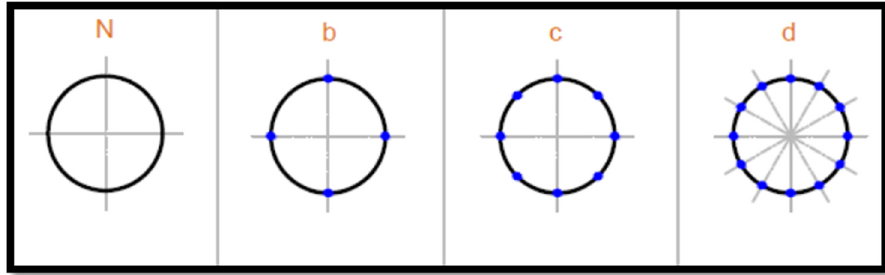
Figure 6: Grouting points grid after footing construction, grouting to a depth